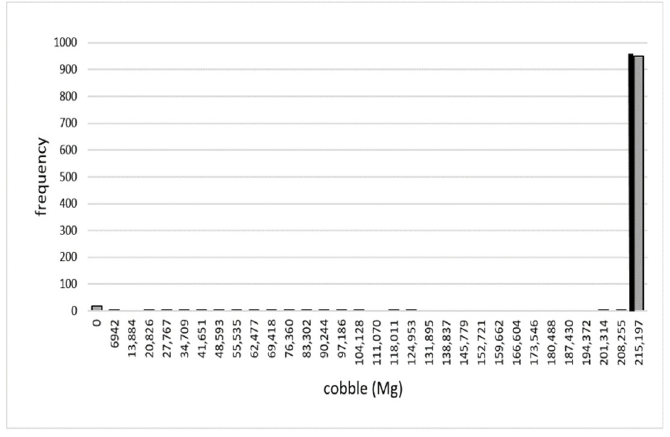
Figure A14. Histogram showing frequencies of achieving given quantity of sales of cobble for mine “E” with σ yprog .